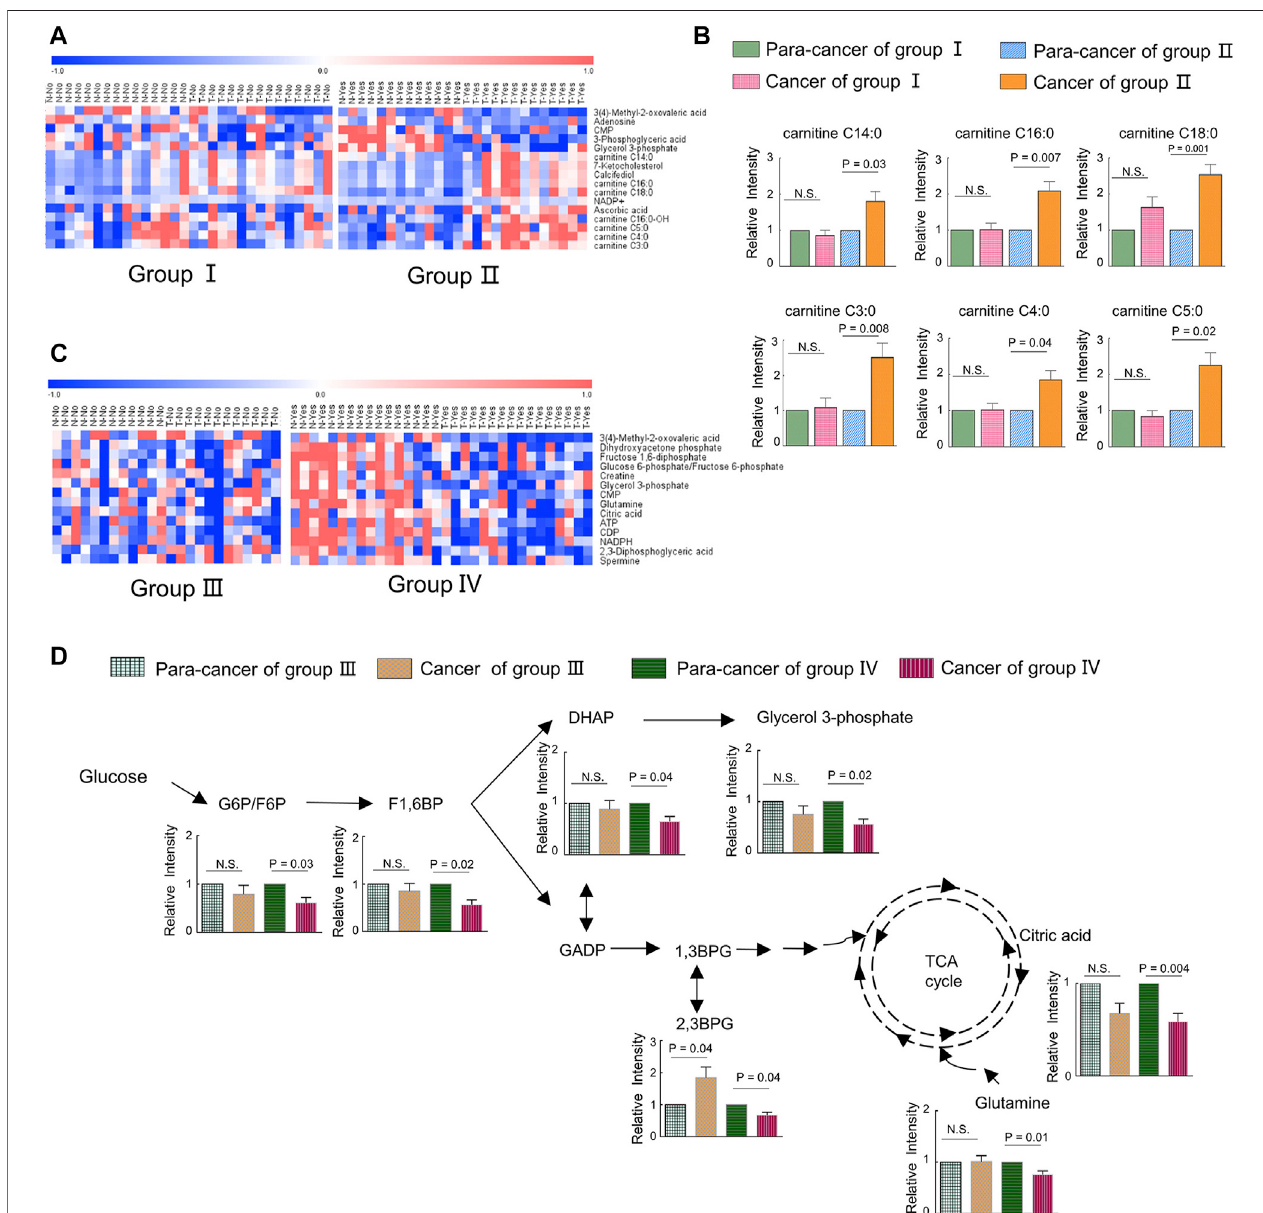
FIGURE 5 | Metabolic adaptions related with a highly expressed ILF2 and ILF3 in ESCC. (A) . Heatmap analysis of differential metabolites according to the expressionofILF2inESCCtissues.Patientsingroup Ⅱ exhibitedhigherILF2levelsintumortissuesthanthoseinthepara-tumortissues,andothercaseswereingroup Ⅰ . (B) . Alterations of acyl-carnitines in ESCC cases with ( n (cid:2) 13, group Ⅱ ) or without ( n (cid:2) 15, group Ⅰ ) highly expressed ILF2 in tumor tissues. (C) . Heatmap analysis of differentialmetabolitesaccordingtotheexpressionofILF3inESCCtissues.Patientsingroup Ⅳ exhibitedhigherILF3levelsintumortissuesthanthoseinthepara- tumor tissuesandotherswereingroup Ⅲ . (D) .In fl uencedglycolysispathwayinESCCcaseswith( n (cid:2) 16,group Ⅳ )orwithout( n (cid:2) 12,group Ⅲ )highlyexpressedILF3in tumor tissues. Data were expressed as mean ±